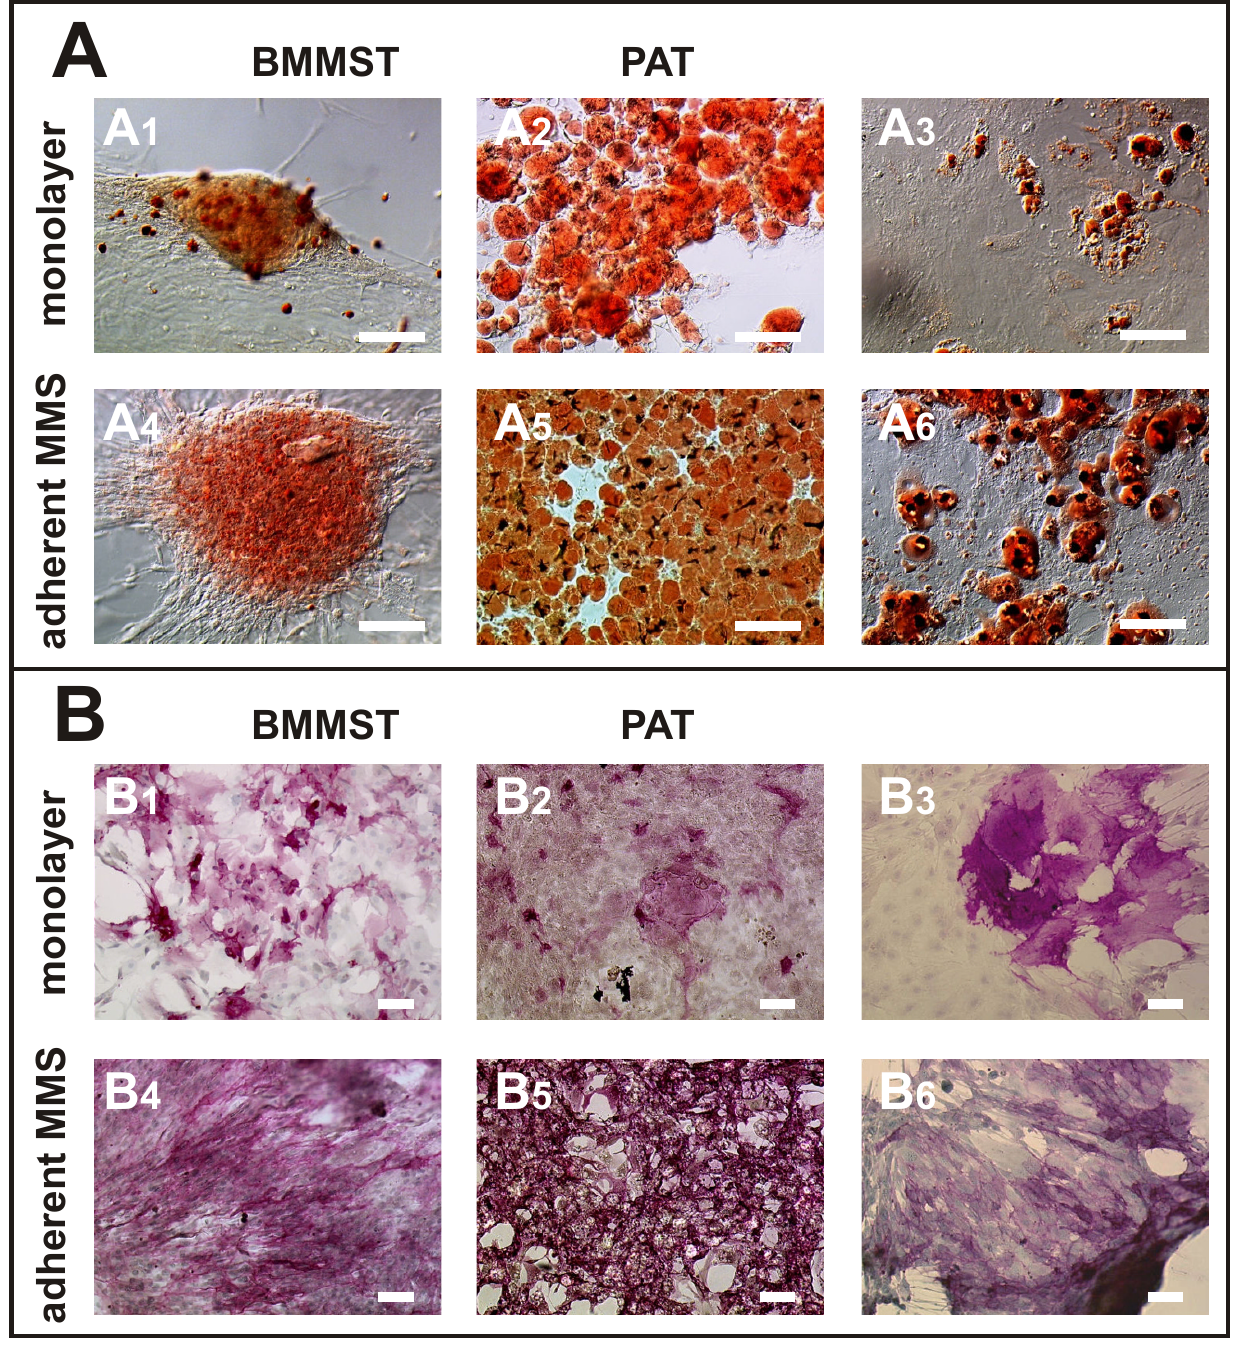
Figure 5 Mesenchymal progenitor cells derived from murine bone marrow (BM), perirenal adipose tissue (PAT), and mediastinal stromal tissue (MST) show adipogenic (A; Sudan III staining) and osteogenic (B; alkaline phos- phatase staining) differentiation. Cells were cultivated via monolayer (A1-3 and B1-3) or adherent "mesenchymal micro- sphere" (MMS outgrowths; A4-6 and B4-6). Representative areas are shown. Bar = 100 μ